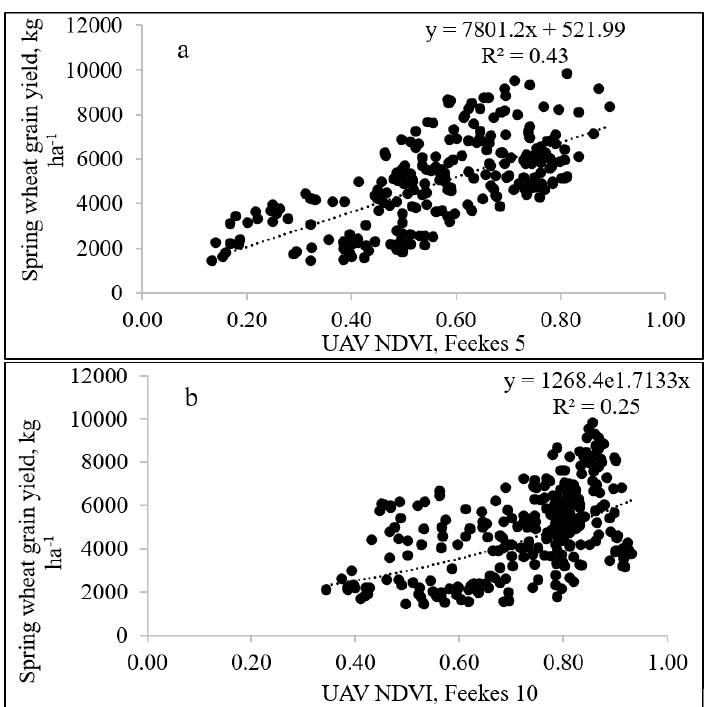
Figure 4. Relationship between Normalized Difference Vegetative Index (NDVI) at Feekes 5 ( a ) and Feekes 10 ( b ) growth stages collected using the Unmanned Aerial Vehicle (UAV) 3D Robotics 8X+ octocopter equipped with MicaSense Red Edge ™ 3 Multispectral Camera and spring wheat grain yield (kg ha −1 ) for 14 site-years in Idaho, 2015 – 2017.